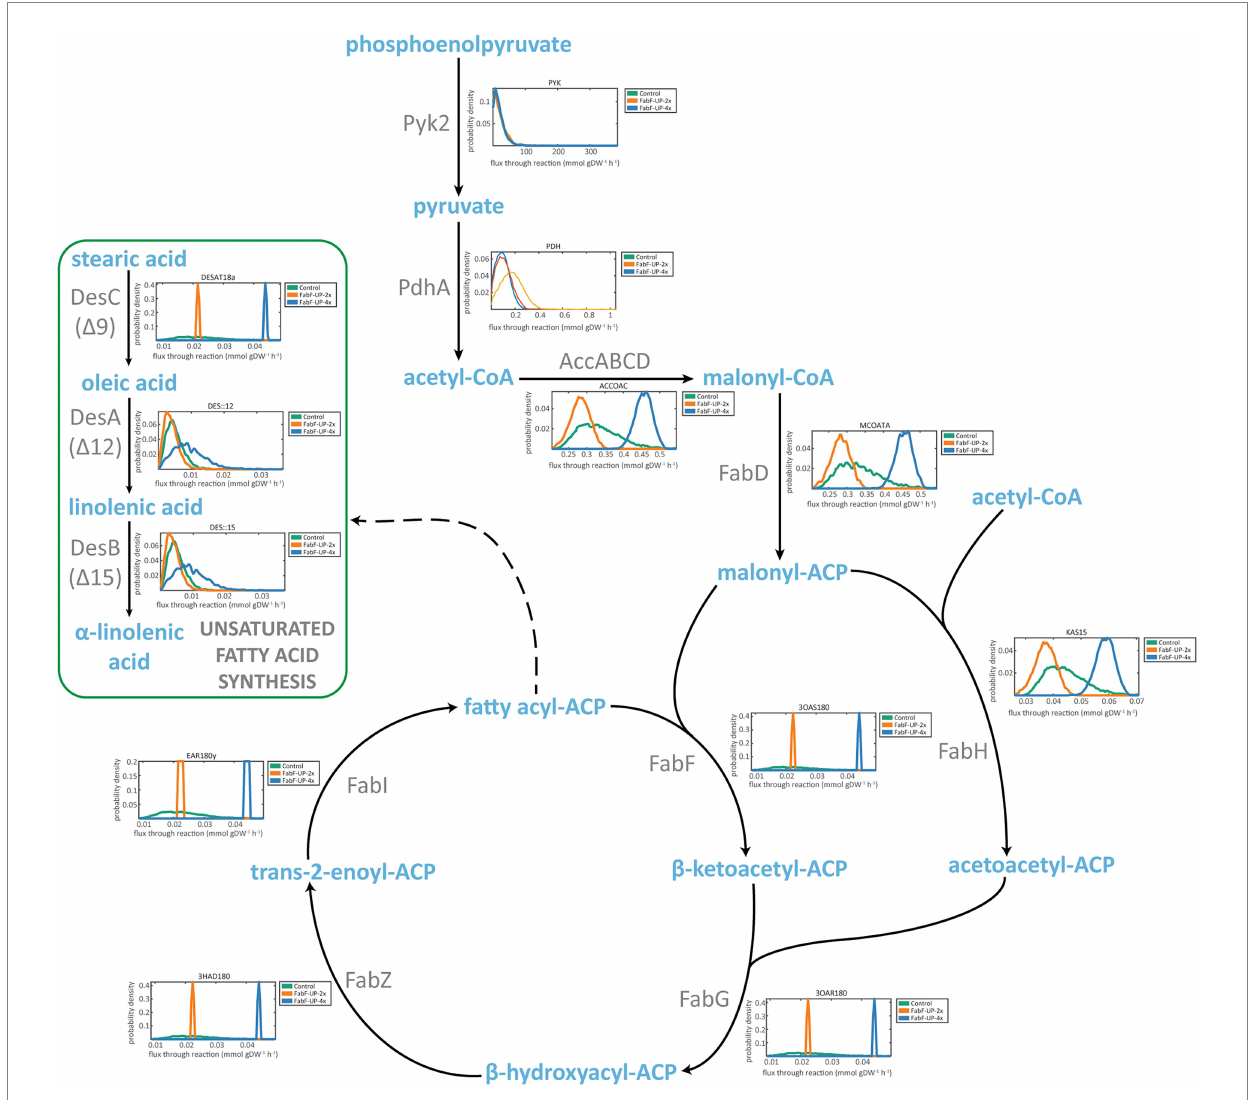
FIGURE 3 Flux sampling distributions of main reactions of ALA synthesis for in silico FabF overexpression mutants and predicted using i MS837. For each reaction, a plot of the probability density versus the predicted flux of the specific reaction is represented. In green, the results obtained for i MS837_ALA are represented (Control); in orange, an in silico designed strain that has double flux for FabF reaction (3OAS180) than i MS837_ALA (FabF-UP-2x); and in blue, an in silico designed strain that has quadruple flux for FabF reaction (3OAS180) than i MS837_ALA